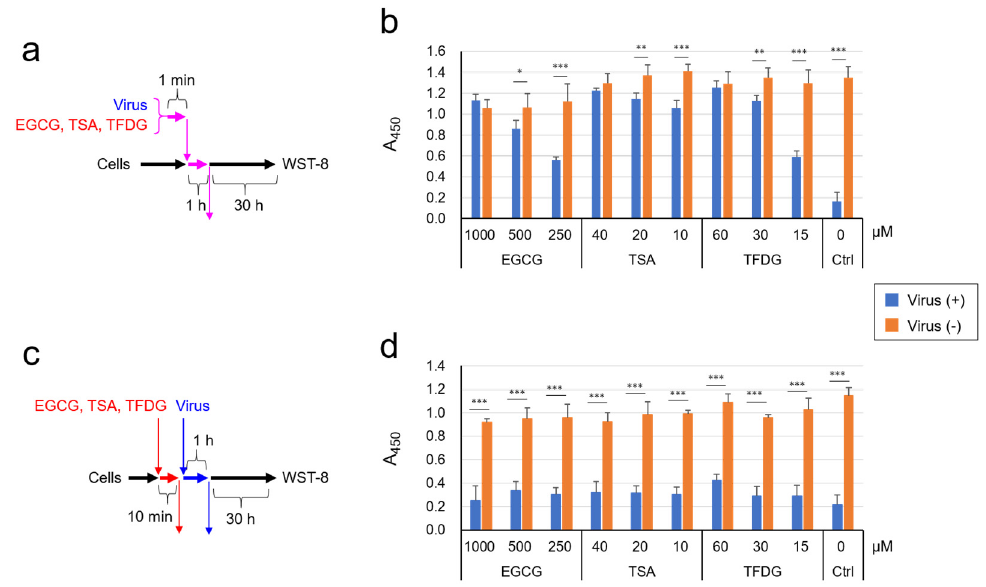
Figure 4. EGCG, TSA, and TFDG inactivated SARS-CoV-2, but did not render cells resistant to intact virus. ( a , b ) Virus was treated with each compound at the indicated concentrations for 1 min, and the mixture was added to VeroE6/TMPRSS2 cells at MOI = 3 for 1 h. After removal of the supernatant, cells were cultured in fresh MS for 30 h, followed by cell viability evaluation as described in the Materials and Methods section. ( c , d ) Cells were pretreated with the indicated concentrations of the compounds for 10 min, followed by a removal of the supernatant, wash with PBS, and an addition of virus suspension (MOI = 5). One hour later, supernatant was replaced by fresh MS, and cells were culture for 30 h until cell viability was evaluated. Values are means ± S.D. ( n = 3). * p < 0.05, ** p < 0.01 and *** p < 0.001 between groups by Student’s t test.